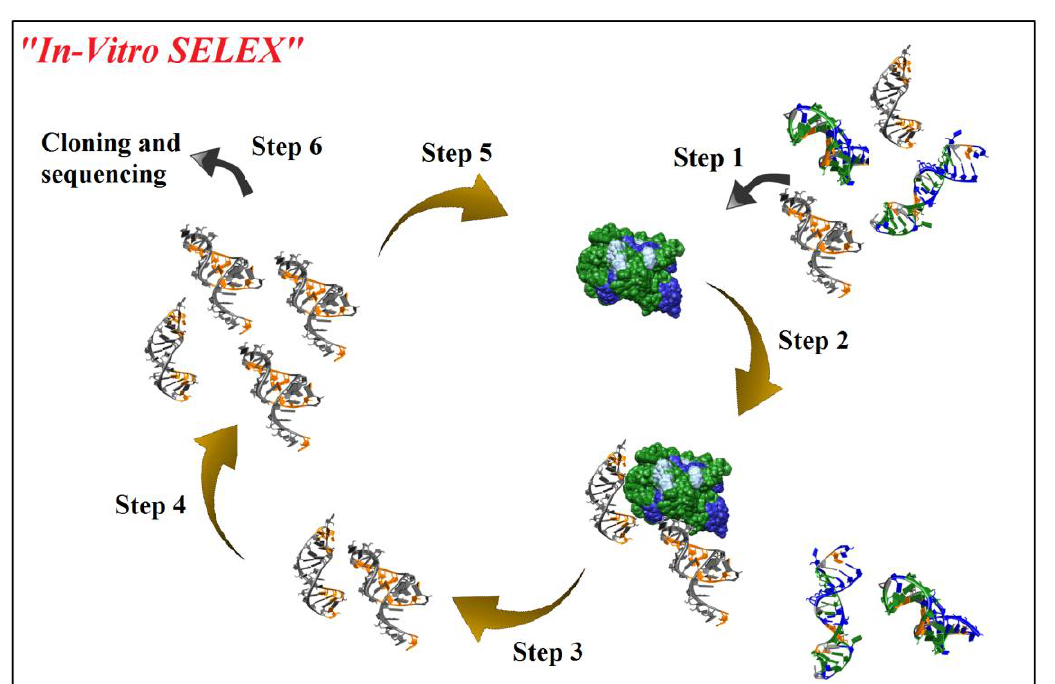
Figure 1. Schematic of in vitro- Systematic Evolution of Ligands by EXponential enrichment (SELEX; upper panel ) and Cell-Internalization SELEX methodologies ( lower panel ). For in vitro- SELEX, a library of RNA molecules is incubated with the target (e.g. recombinant protein) (Step 1) and binders are separated from non-binders (Step 2). Recovered binders (Step 3) are subsequently amplified (Step 4) to generate a pool of molecules that displays high affinity and specificity for the target. For cell-internalization SELEX, a library of RNA molecules is incubated with non-target cells (counter selection) (Step 1) and those RNAs that do not bind (supernatant) are then transferred to the target cells (Step 2). The cell incubations are performed at 37  C to facilitate cell internalization (Step 3). A stringent wash step (high salt wash, trypsin wash) is then performed to remove unbound and/or surface bound RNA. The internalized RNA is recovered using TRIzol extraction (Step 4) and amplified by PCR (Step 5). The process is repeated several more times to enrich for RNA sequences with cell-specific, internalizing properties (Step 6). The enriched pool of RNA is then subjected to cloning and sequencing (Step